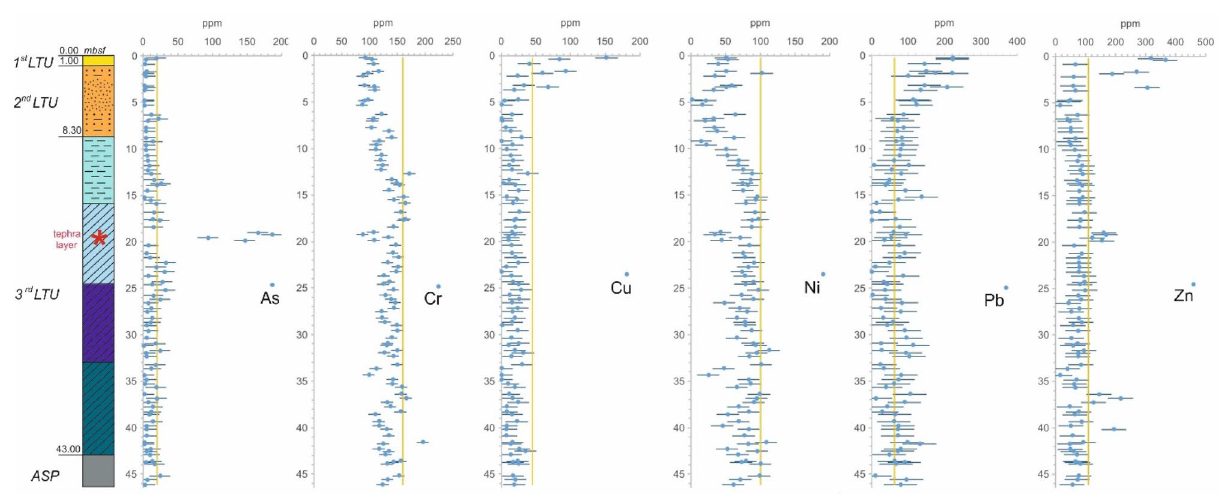
Figure 14. PXRF chemical profiles acquired through the scanning of the cores from S3. For each data, the error bar is also shown. The yellow line represents the Taranto Site threshold 53 . Note the geochemical anomalies at 19–21 m depth, corresponding to a tephra